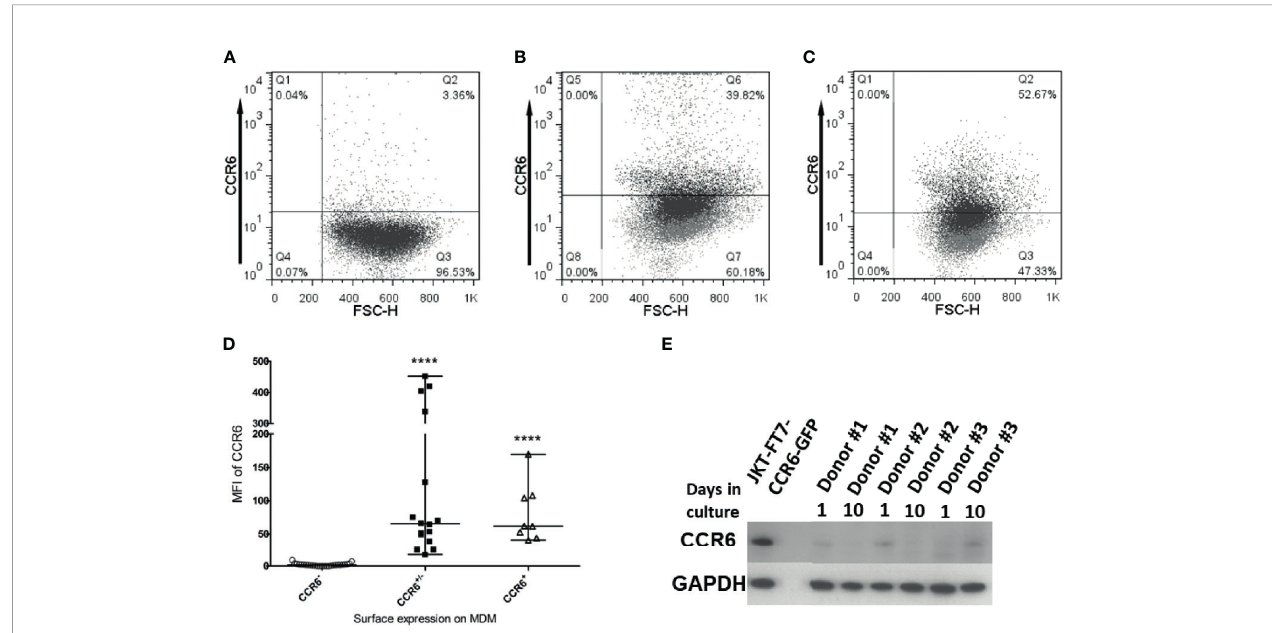
FIGURE 5 | CCR6 is expressed on macrophages. Untreated, uninfected MDM were harvested and stained for fl ow cytometry analysis of CCR6 as described in Materials and Methods . Data analyses were performed using FlowJo software. Forward scatter dot plots show the fl uorescence and percentage of cells positive for CCR6 as compared to the respective isotype-matched control. A representative of each type (A) CCR6 - , (B) CCR6 +/- , and (C) CCR6 + is shown. (D) Median Fluorescence Intensity (MFI) values for CCR6 surface expression (as compared to MFI for isotype control) on MDM from different donors designated as either CCR6 - , CCR6 +/- , or CCR6 + . Data are presented as median and range of MFI values. Each dot represents one donor. ****P < 0.0001 between CCR6 +/- and CCR6 - or CCR6 + and CCR6 - determined with unpaired two-tailed t test. (E) Immunoblot analysis of CCR6 on MDM from 3 donors, 1 day and 10 days of tissue culture